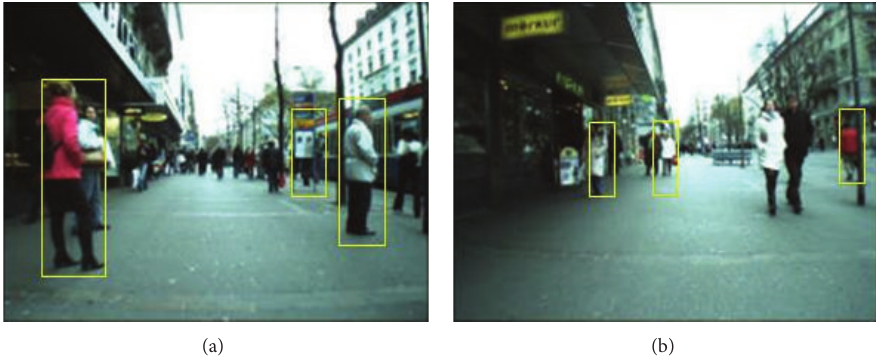
Figure 8: (a) False positives detection and (b) false negative detection.